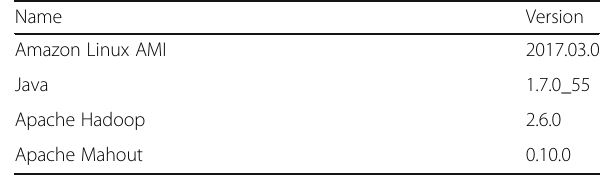
Table 1 Cluster hardware configurations Table 2 Cluster software